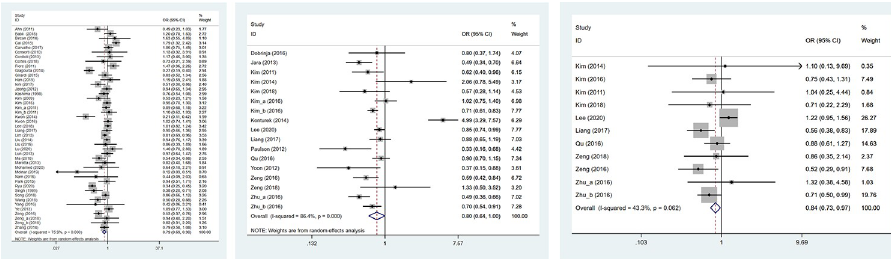
Fig 2. The forest plot of lymph node metastasis between HT group and non-HT group; (a) overall analysis of lymph node metastasis; (b) central lymph node metastasis; (c) lateral lymph node metastasis.